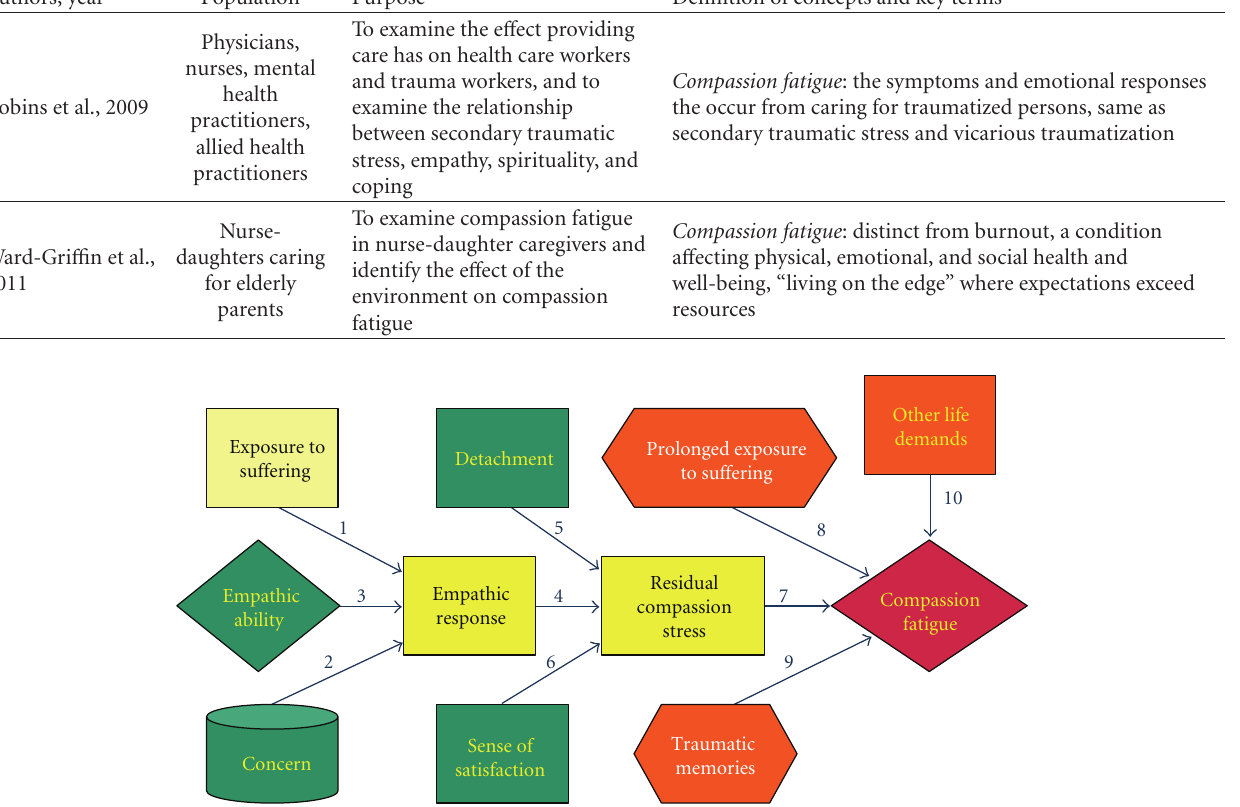
Figure 1: Compassion fatigue process